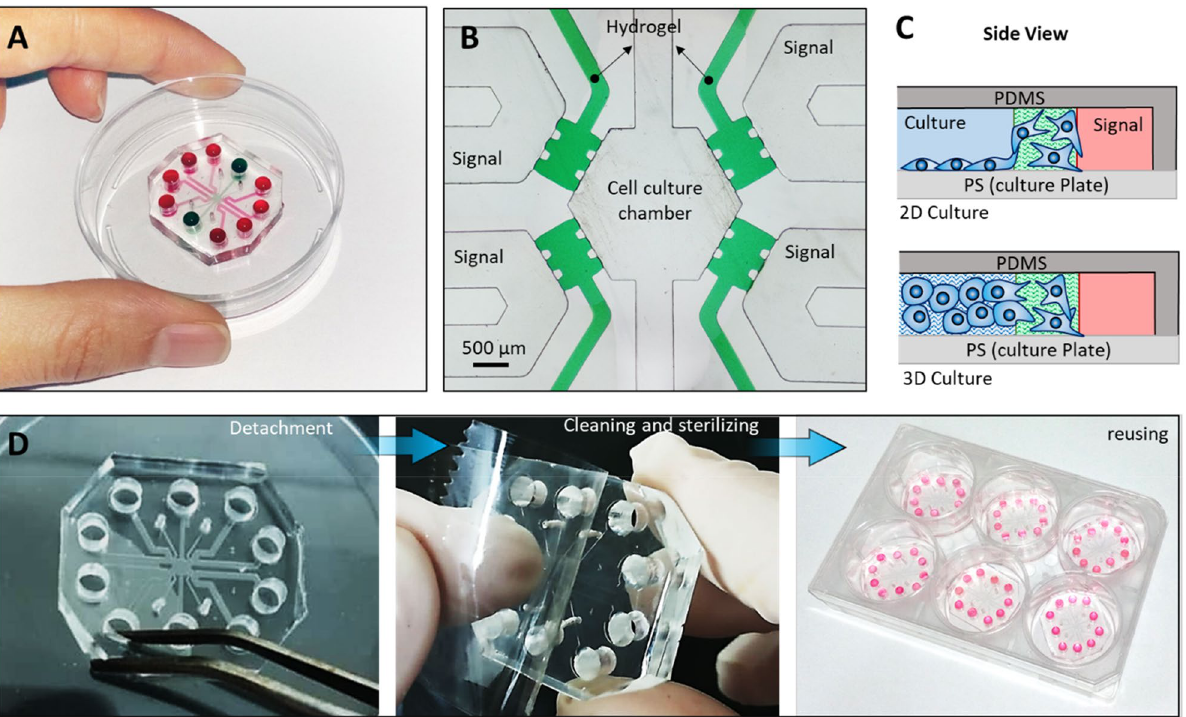
Figure 1. Stand-alone and reusable microfluidic gradient generator for investigation of cellular behavior. ( A ) The device is formed by direct mounting of the Polydimethylsiloxane (PDMS) microfluidic chip on the polystyrene (PS)-based culture dishes or plates. ( B ) The microfluidic network consists of four signal channels separated from a cell culture channel using hydrogel barriers. The hydrogel is confined in the specified microchannel by application of micro-posts and due to the hydrophobic nature of PDMS. ( C ) The device can be used directly for two- or three-dimensional cell culture applications and offers the opportunity for investigating cellular invasion into biomimetic extracellular matrices (ECMs). ( D ) The device is detachable and can be reused after minimal cleaning and